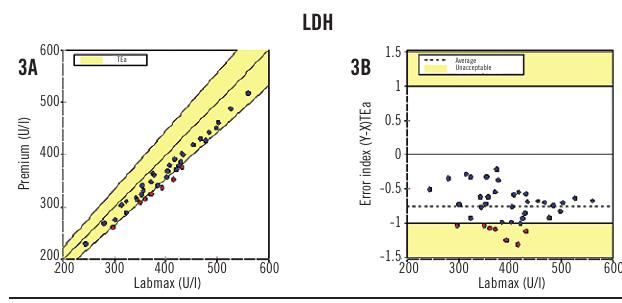
figurE 1 − Comparisons between ALT measurement for 2 automated chemistry platforms A) linear regression for ALT measurements between instruments Labmax 240 ® (E1) and Labmax 240 Premium ® (E2): n = 40, r = 0.992, p < 0.05; equation for the correlation: E2 = 0.98*E1 - 0.3; TEa = 27.5%; B) graph comparing the systems Labmax 240 ® (E1) and Labmax 240 Premium ® (E2) for ALT measurement: error index = [(result - mean)/TEa]